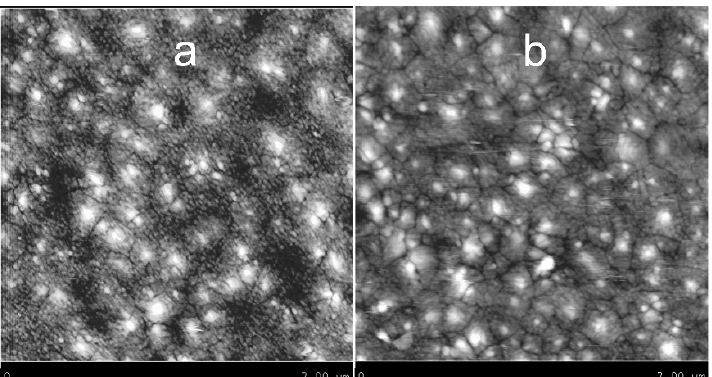
Figure 4. AFM images (2 µm × 2 µm) of WO 3 films annealed at 400 °C ( a ) and 500 °C ( b ) for 6 h. Insets: zoomed AFM images (500 nm × 500 nm).